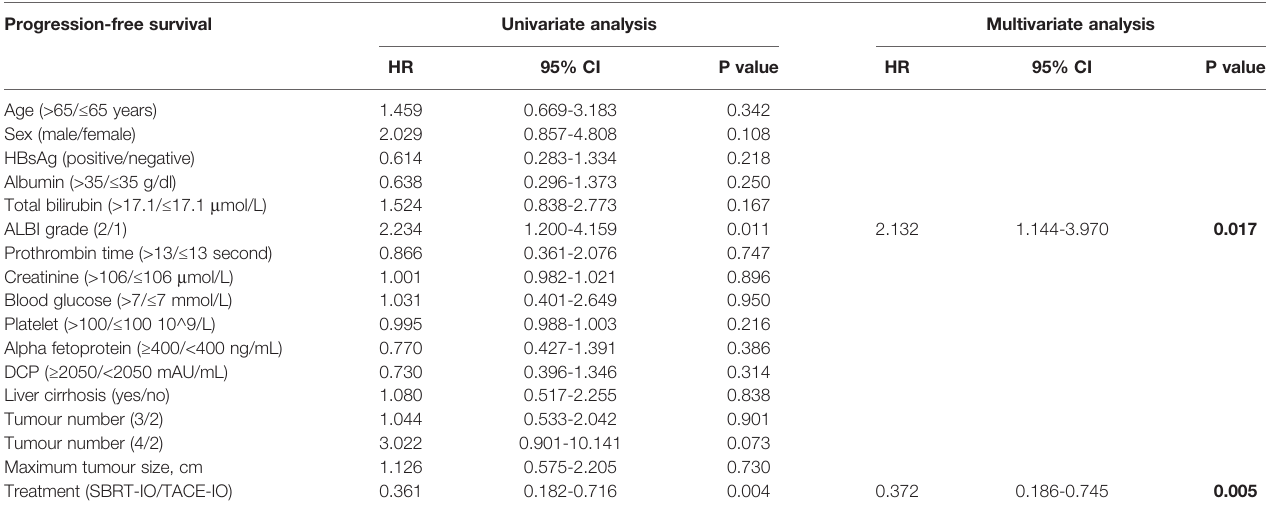
TABLE 2 | Prognostic factors for progression-free survival. Progression-free survival